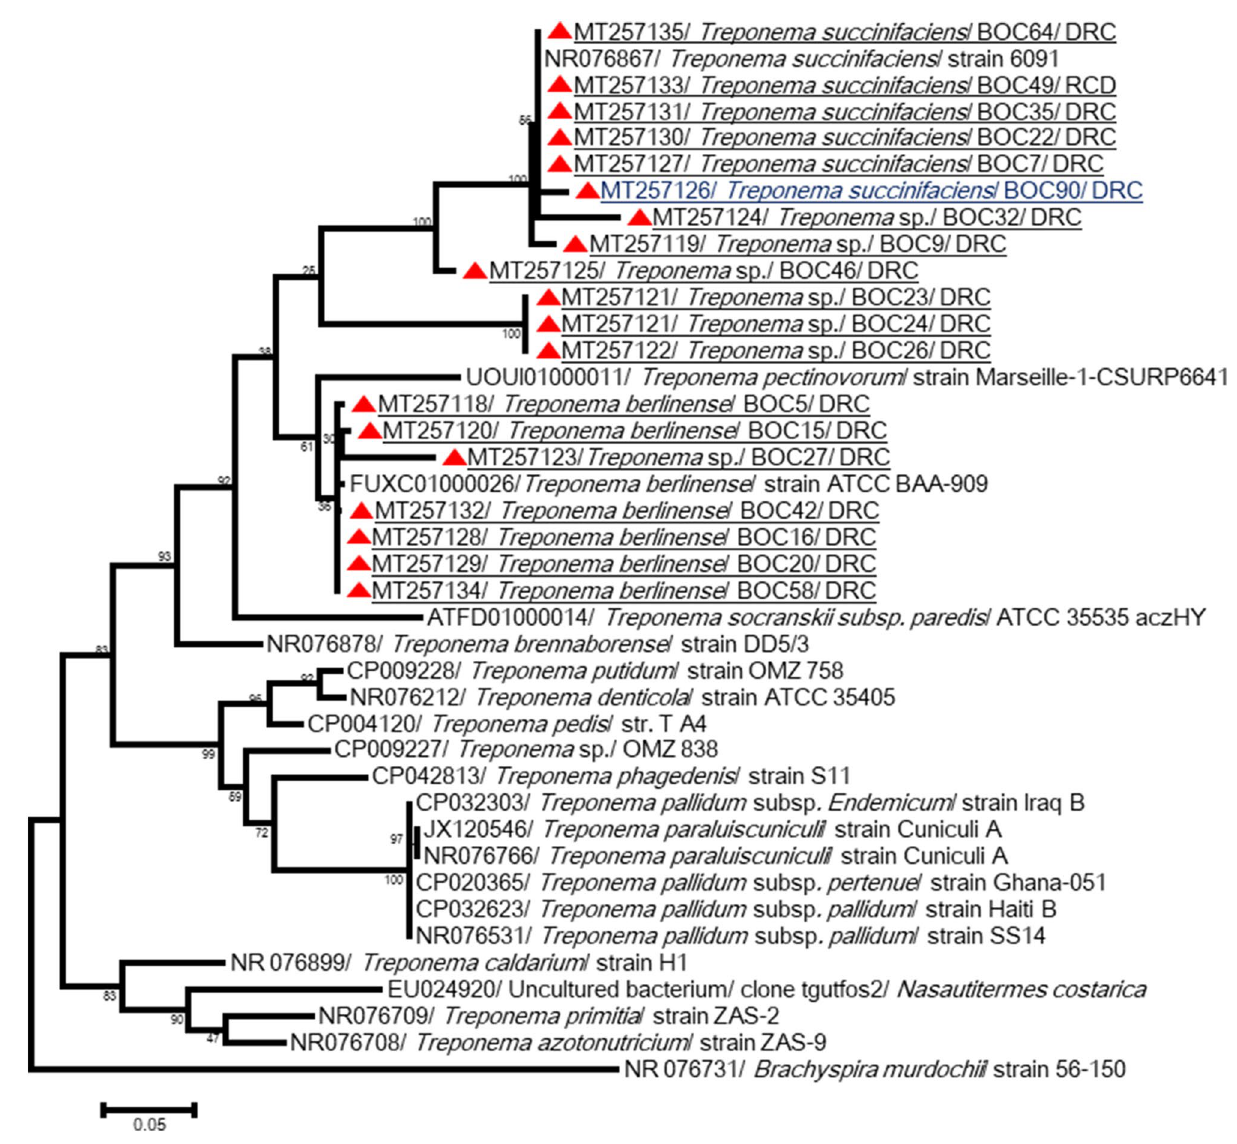
Figure 5. Molecular Phylogenetic analysis for Treponema spp. detected on bonobos from DRC. The evolutionary history, based on partial 23S rRNA gene, was inferred by using the Maximum Likelihood method based on the Tamura 3-parameter model. Initial tree for the heuristic search were obtained automatically by applying Neighbor-Join and BioNJ algorithms to a matrix of pairwise distances estimated using the Maximum Composite Likelihood (MCL) approach, and then selecting the topology with superior log likelihood value. Sequences are identified as follows: accession number/species/strain/host/country. Sequences in this study are highlighted by black circle and underlined. Sequence wrote in bleu was obtained on a wild bonobo sample while all the others obtained on semi-captive bonobo samples. In addition, in bolt are the Treponema spp. sequences from African NHPs. The tree is drawn to scale, with branch lengths measured in the number of substitutions per site. The analysis involved 48 nucleotide sequences. All positions containing gaps and missing data were eliminated. There were a total of 721 positions in the final dataset. Evolutionary analyses were conducted in MEGA7 61